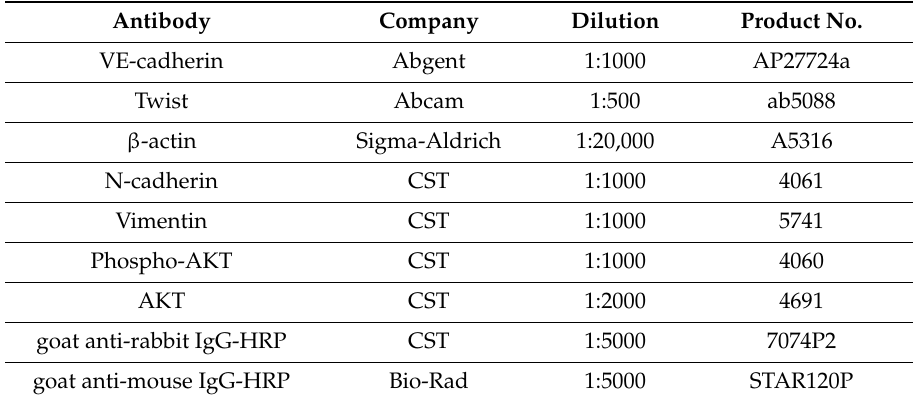
Table 1. Antibodies used in this study. VE—vascular endothelial.